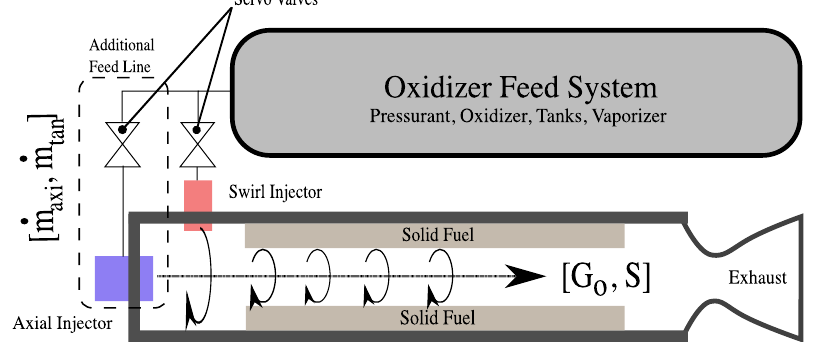
Figure 1. A-SOFT (Altering-intensity Swirling-Oxidizer-Flow-Type) concept with dual front oxidizer injections